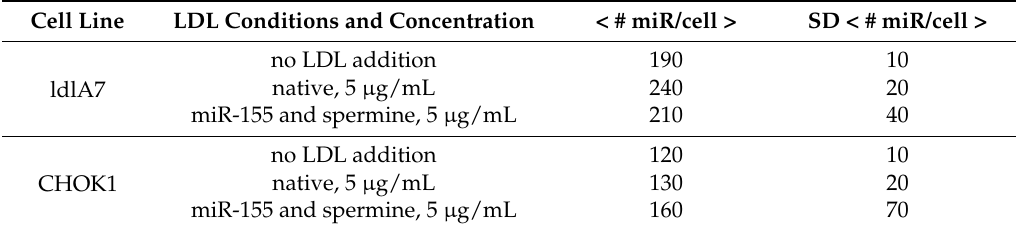
Table 5. * Influence of lipoprotein particle receptor density on cellular miRNA-content before/after LDL particle